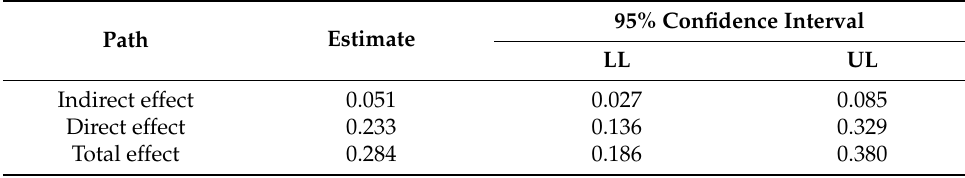
Table 6. Direct effect, indirect effect, and total effect.